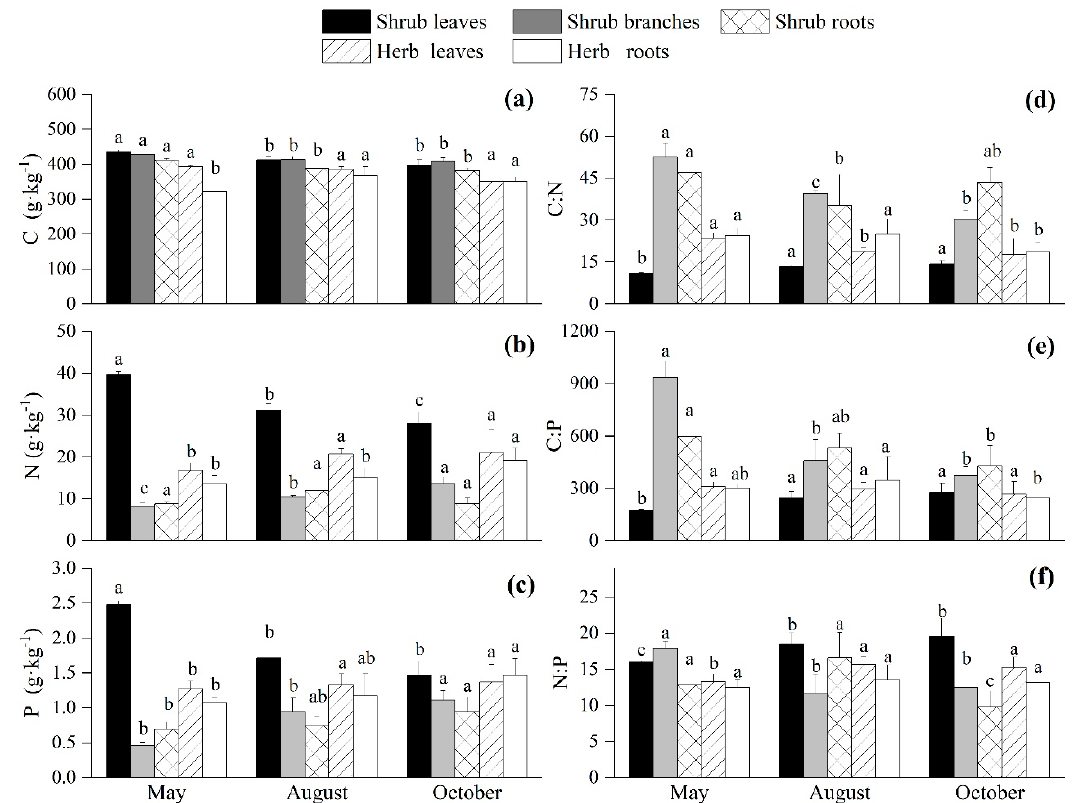
Figure 3. Seasonal variations of the C, N, and P contents and ratios in shrub and herb layers. ( a ) describes the C content of understory vegetation; ( b ) describes the N content of understory vegetation; ( c ) describes the P content of understory vegetation; ( d ) describes the C:N ratio of understory vegetation; ( e ) describes the C:P ratio of understory vegetation; ( f ) describes the N:P ratio of understory vegetation. Different small letters over the bars represent the significant differences among the different growing seasons at P < 0.05.